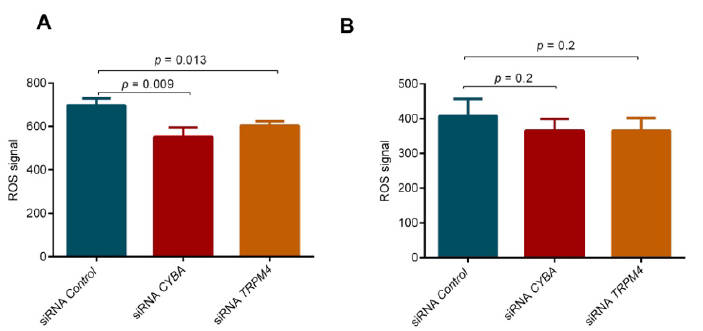
Figure 5. ROS activity upon CYBA or TRPM4 knockdown. CYBA or TRPM4 depletion led to significant reduction of ROS in LS174T cells ( A ), but no decrease in HT-29 cells ( B ). Three independent experiments in triplicate were performed, and means and standard errors of the means are presented on the graphs.